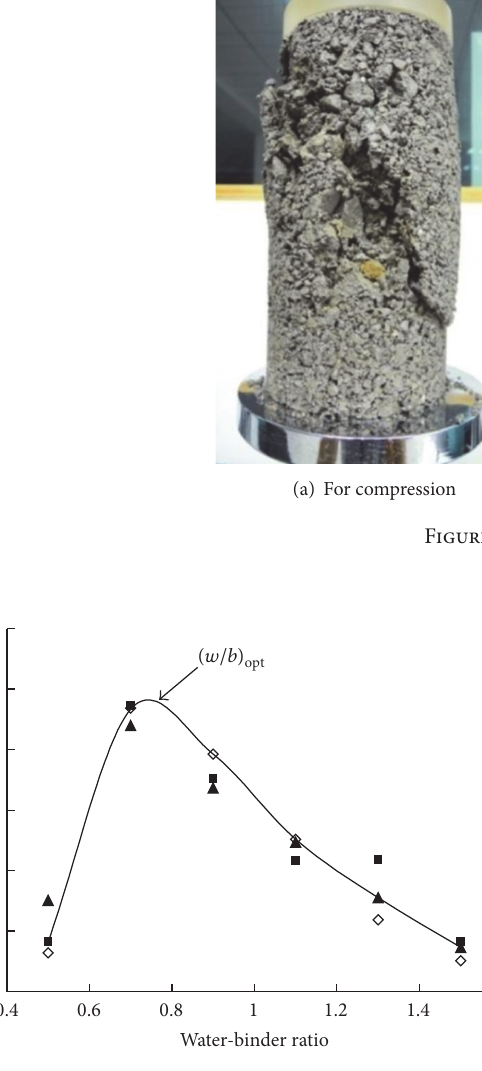
Figure9:Variationofunconfinedcompressivestrengthfordifferent water-binder ratios.